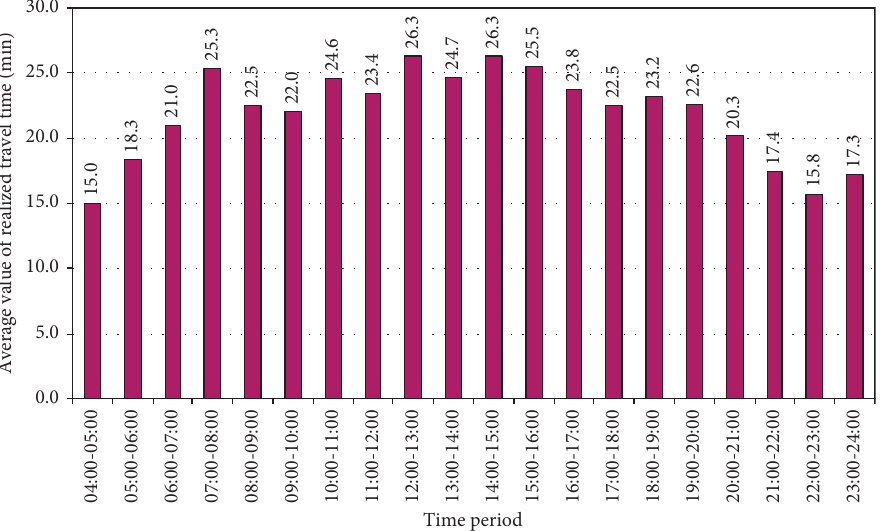
Figure 7: Average value of travel time, by hours in a day, observed in direction